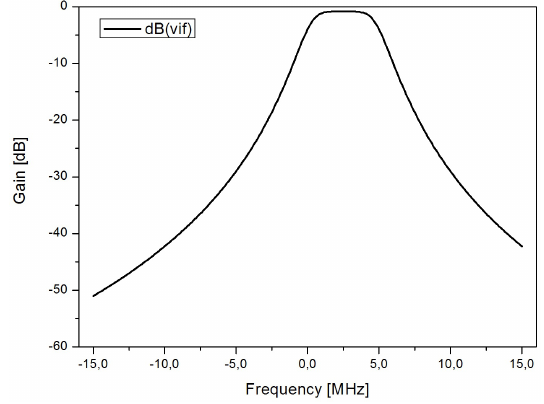
Figure 9. Architecture of the proposed low-IF conventional receiver.